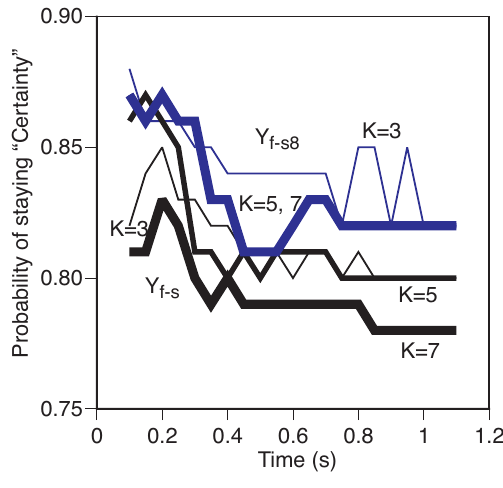
Figure 6. Probability changes of remaining in “Certainty” with Y f (cid:0) s and Y f (cid:0) s 8 .